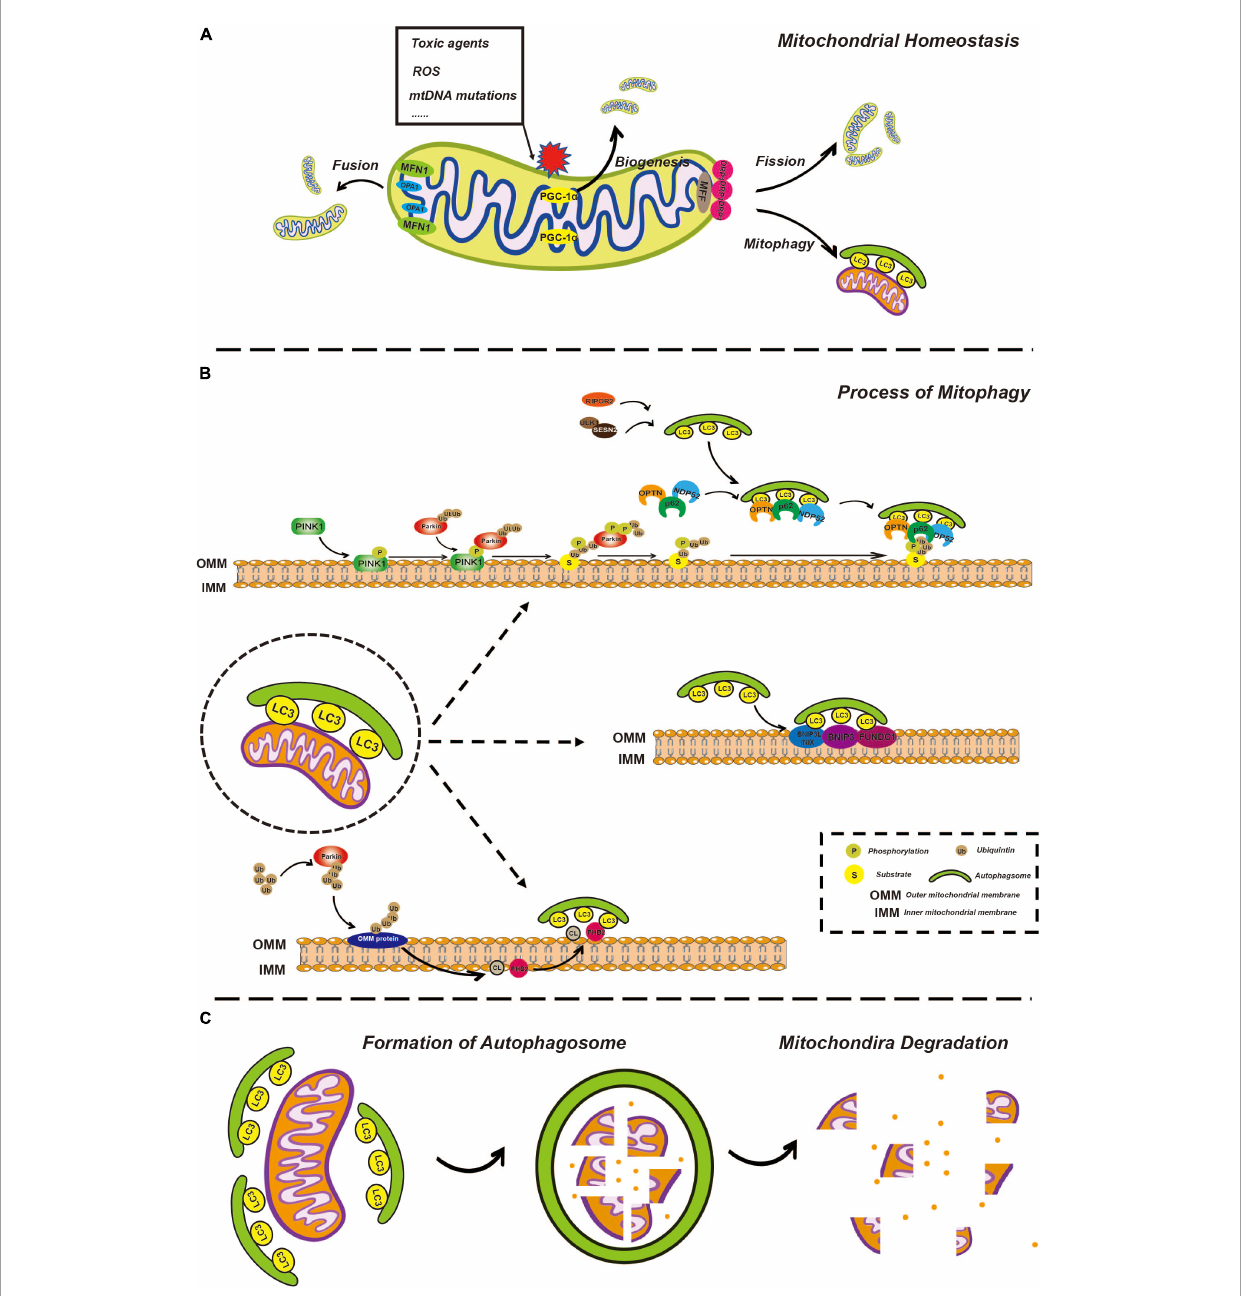
FIGURE1 Overview of mitophagy. (A) Overview of mitochondria fusion, fission, and biogenesis. Healthy mitochondria constantly undergo fusion and fission processes, allowing for the exchange of genetic material and the maintenance of optimal mitochondrial shape and function. Fusion of two or more mitochondria results in a larger, more complex structure through the action of fusion proteins such as mitofusins (MFN1 and MFN2) and opticatrophy 1 (OPA1). Fission of a single mitochondrion into smaller, individual units helps to distribute energy evenly throughout the cell and is mediated by the fission protein, dynamin-related protein 1 (DRP1). Mitochondrial biogenesis involves the creation of new mitochondria through the process of replication and division of existing mitochondria, facilitated by the peroxisome proliferator-activated receptor gamma coactivator-1 α (PGC-1 α ) and other biogenesis factors, ensuring that energy production is maintained in the face of changes in cellular demand. (B) The process of mitophagy is regulated by phosphatase and tensin homolog-induced kinase 1 (PINK1)/Parkin-dependent and independent pathways. In the PINK1/Parkin-dependent pathway, damaged mitochondria are recognized by the presence of the kinase protein PINK1. PINK1 activates the E3 ubiquitin ligase Parkin, which targets the damaged mitochondria for degradation by attaching ubiquitin molecules to the damaged mitochondria. The ubiquitin-tagged mitochondria are then enveloped by autophagosomes and delivered to the lysosome for degradation by lysosomal enzymes. In the PINK1/Parkin-independent pathway, damaged mitochondria are recognized by other factors, such as BCL2 interacting protein 3-like (BNIP3L)/NIX, cardiolipin (CL), and prohibitin 2 (PHB2) which then trigger autophagosome formation and subsequent delivery to the lysosome for degradation. (C) Mitochondria degeneration. Autophagosome formation is regulated by a series of autophagy-related proteins, such as microtubule associated protein 1 light chain 3 (LC3). Once the autophagosome has formed, it fuses with a lysosome, allowing for the degradation of the enclosed mitochondria by lysosomal enzymes, including cathepsins. The lysosomal enzymes break down the enclosed mitochondria into its constituent parts, which can then be recycled or eliminated from the